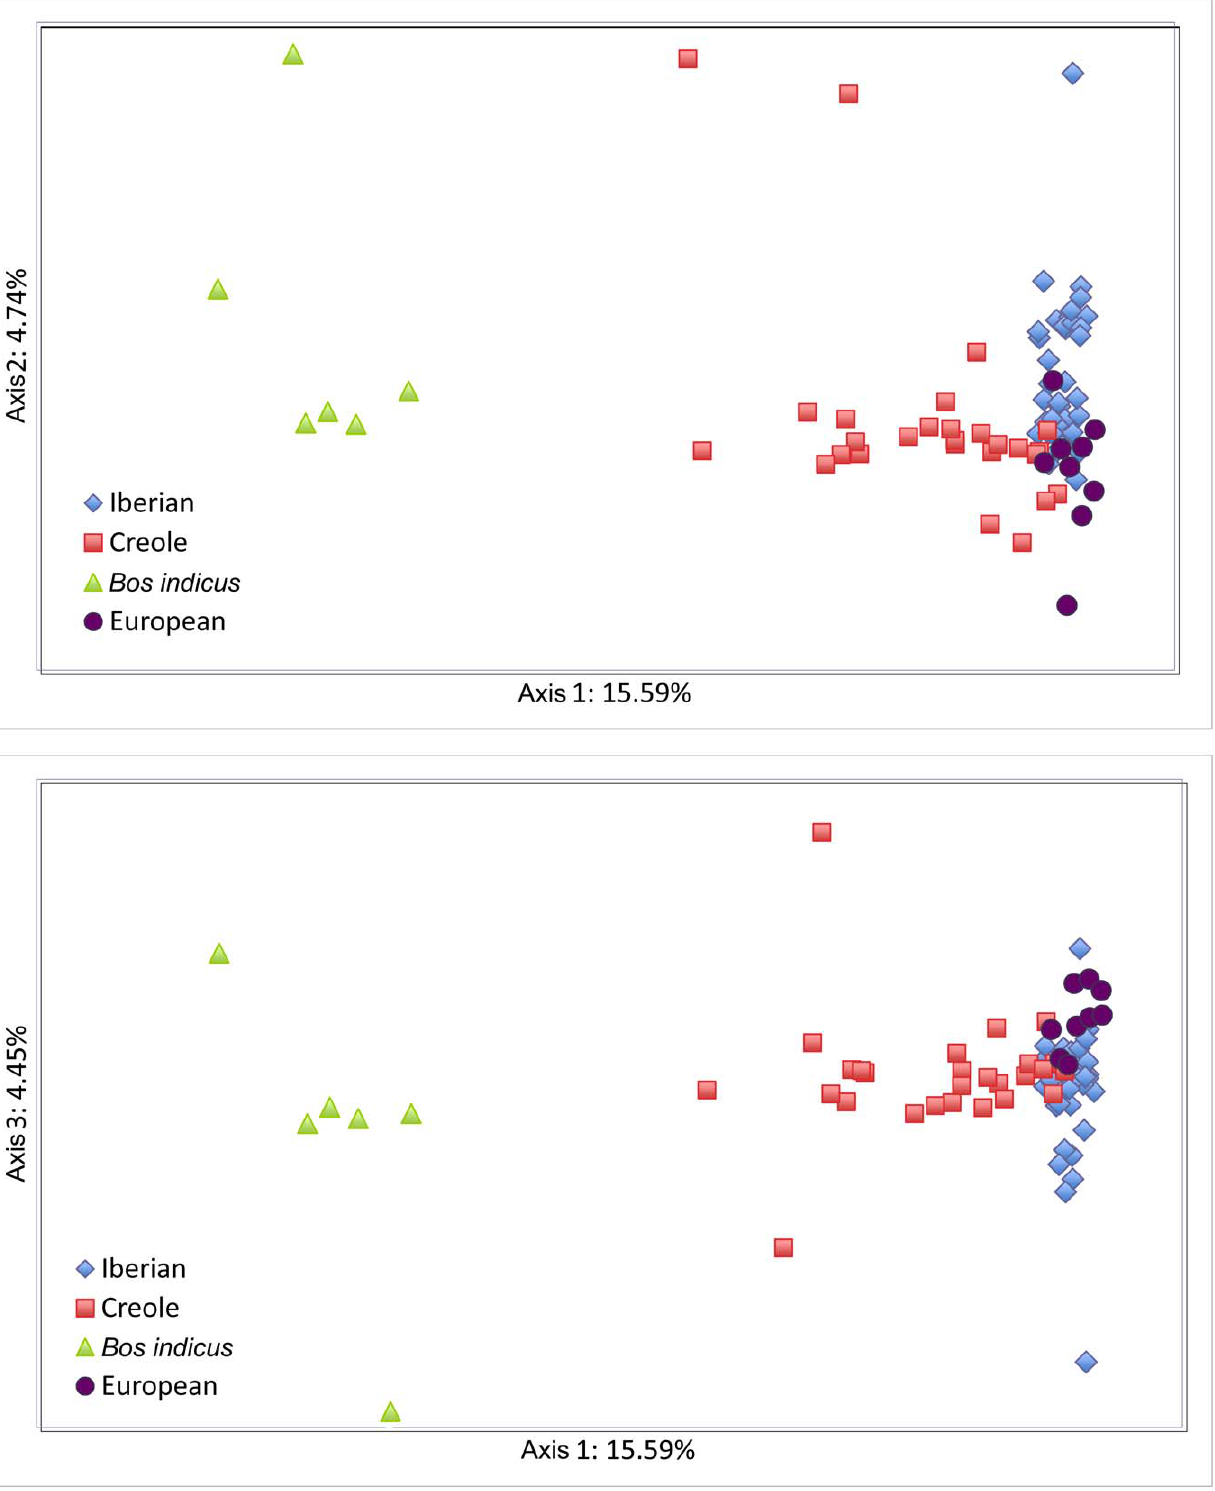
Figure 2. Graphical representation of the three first axes from the factorial correspondence analysis of the 81 cattle breeds from America and Europe.